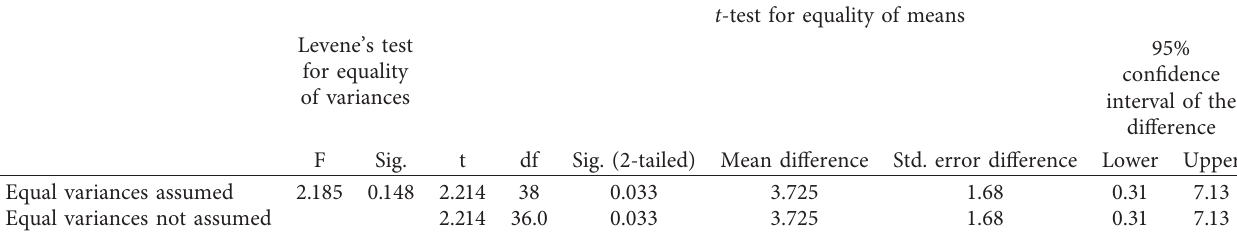
Table 5: Results of independent sample t -test (posttest).